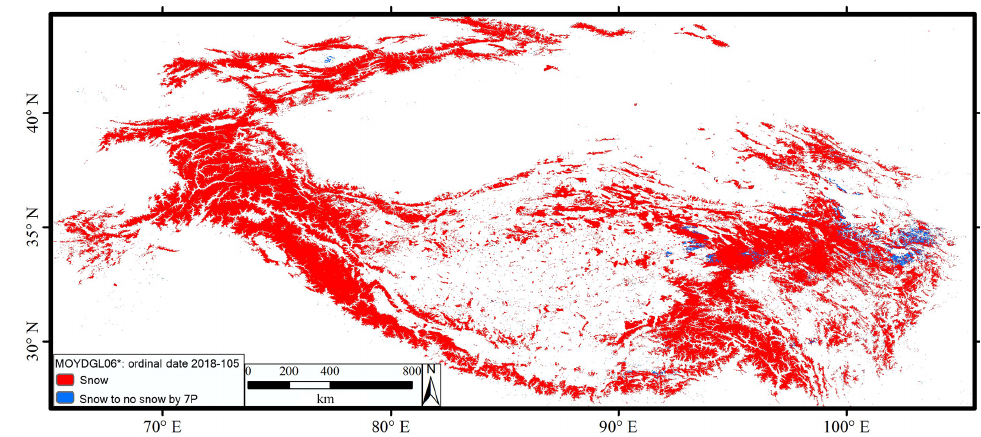
Figure 9. Snow underestimation by a 7% persistency threshold (7P) in the MOYDGL06* product. The red colour is the snow with no changes, whereas blue is the underestimated snow by the persistence threshold.